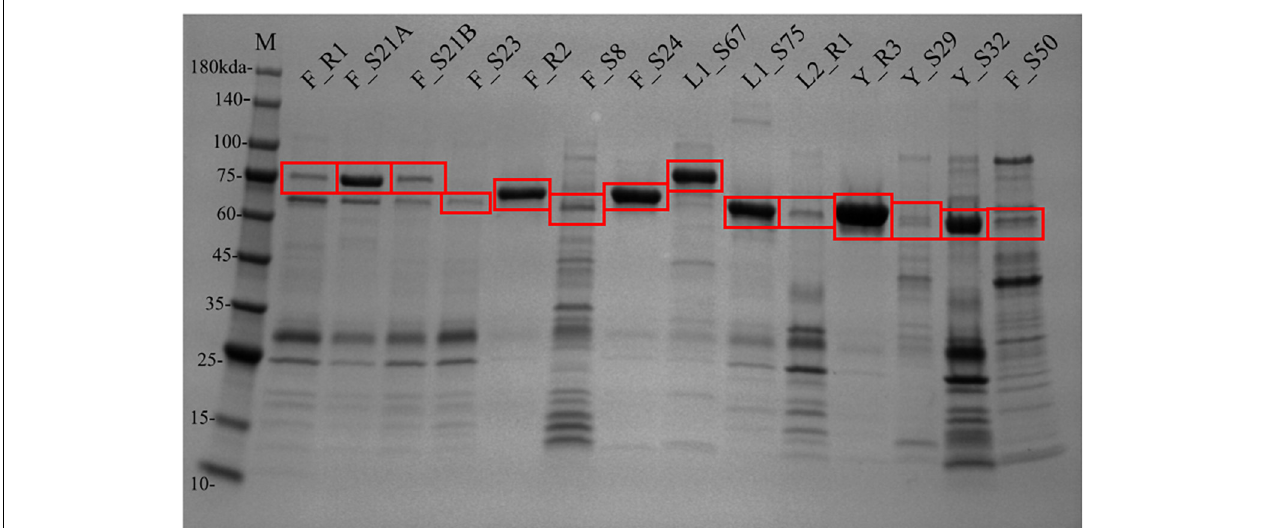
FIGURE 3 | Protein production from synthesized reference and virome sequences. SDS-PAGE gel of 6xHis-tagged proteins from reference and virome clones. Red boxes indicate protein bands of interest (expected PolA size ∼ 64–75 kDa). Prefix of clone names indicate the PolA 762 residue and clade ( Figure 1 ): phenylalanine group (F), leucine clades (L1 or L2), or tyrosine clade (Y); and the character following the underscore indicates the source: reference sequence (R) or virome sequence